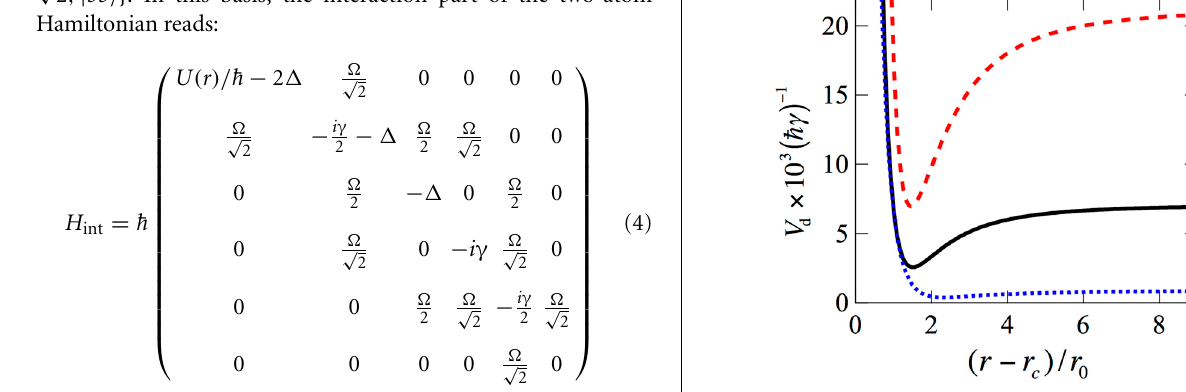
FIGURE 2 | Examples of the dissipative potentials, Equation (6), for different values of parameters. Black solid line: (cid:2) = γ / 4, (cid:3) = γ / 20 (these values correspond to the results of Figures 3 , 4 ); blue dotted line: (cid:2) = γ / 2, (cid:3) = γ / 40; red dashed line: (cid:2) = γ / 12, (cid:3) = γ / 20. The cutoff radius is set to r c = r 0 . The steady-state probability distributions corresponding to these potentials are shown in Figure 5